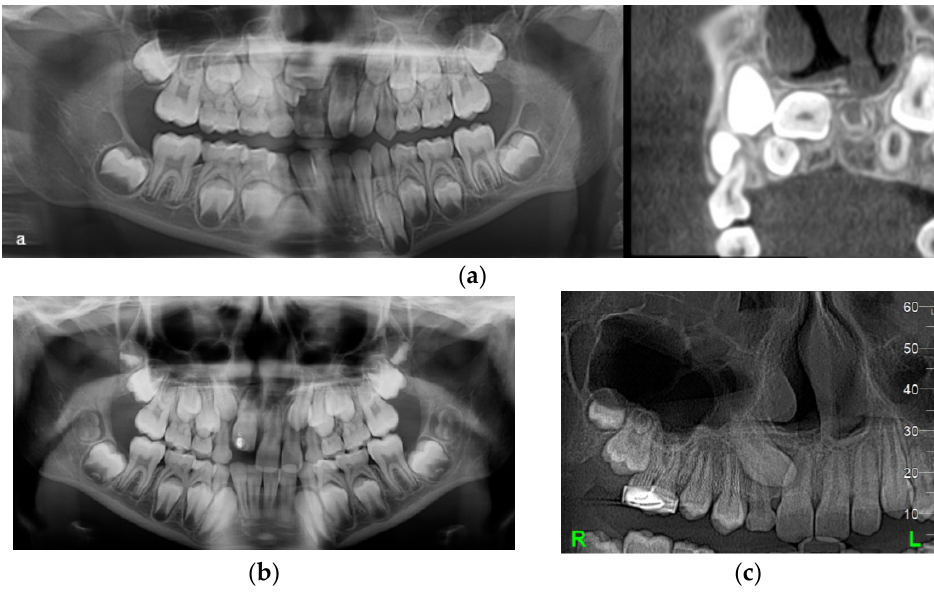
Figure 6. ( a ) Impaction of the central incisor, congenitally missing lateral incisor, and a supernumerary tooth were noticed on the initial panoramic X-ray and CBCT. ( b ) Panoramic X-ray showing the root DL of all the incisors. ( c ) CBCT—upper right impacted canine presenting a DC.